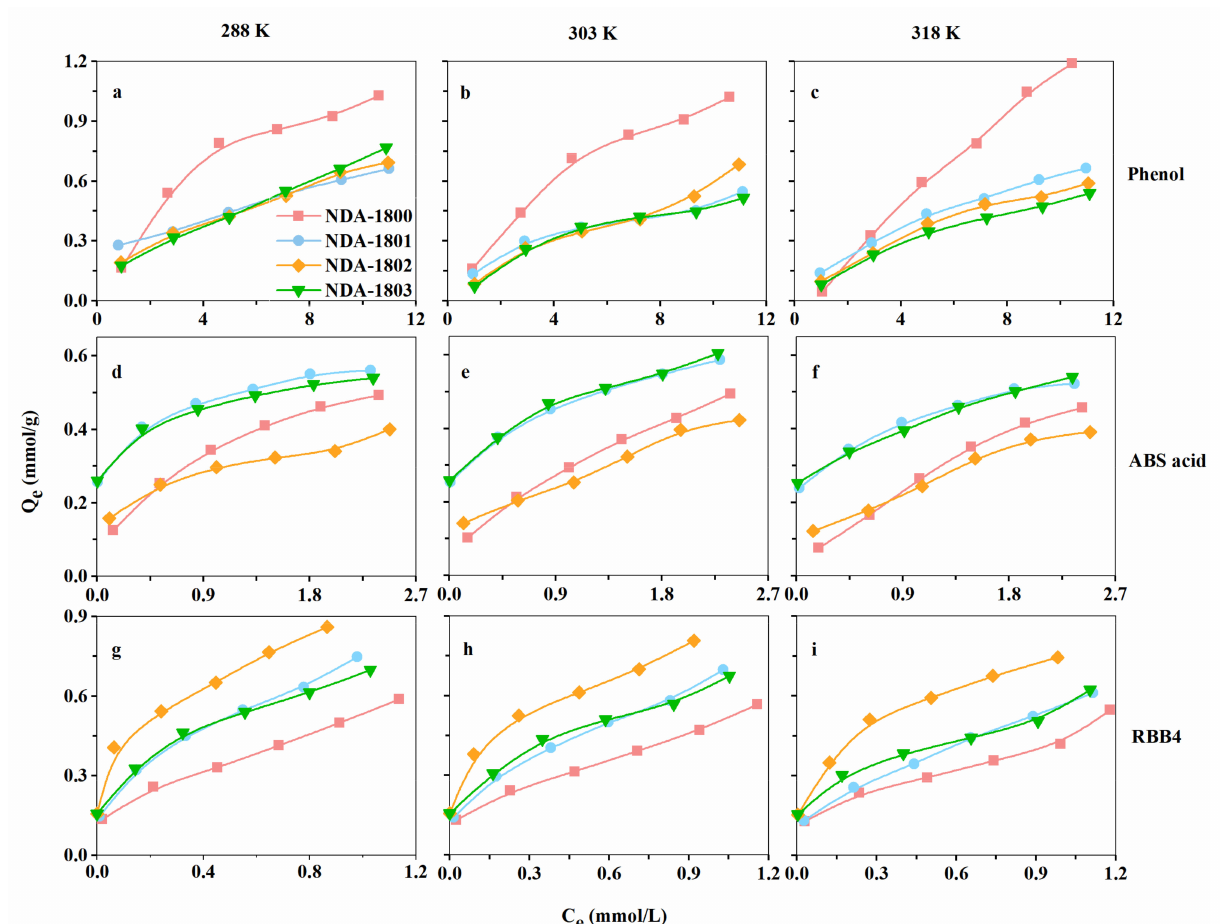
Figure 7. ( a ) Adsorption isotherms of phenol at 288 K; ( b ) Adsorption isotherms of phenol at 303 K; ( c ) Adsorption isotherms of phenol at 318 K; ( d ) Adsorption isotherms of ABS acid at 288 K; ( e ) Adsorption isotherms of ABS acid at 303 K; ( f ) Adsorption isotherms of ABS acid at 318 K; ( g ) Adsorption isotherms of RBB4 at 288 K; ( h ) Adsorption isotherms of RBB4 at 303 K; ( i ) Adsorption isotherms of RBB4 at 318